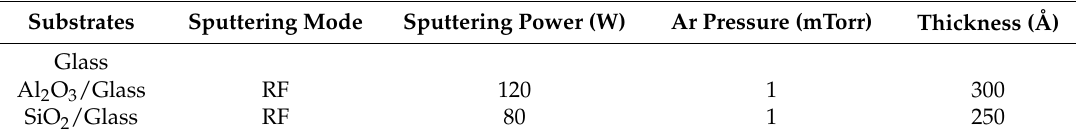
Table 1. Substrate